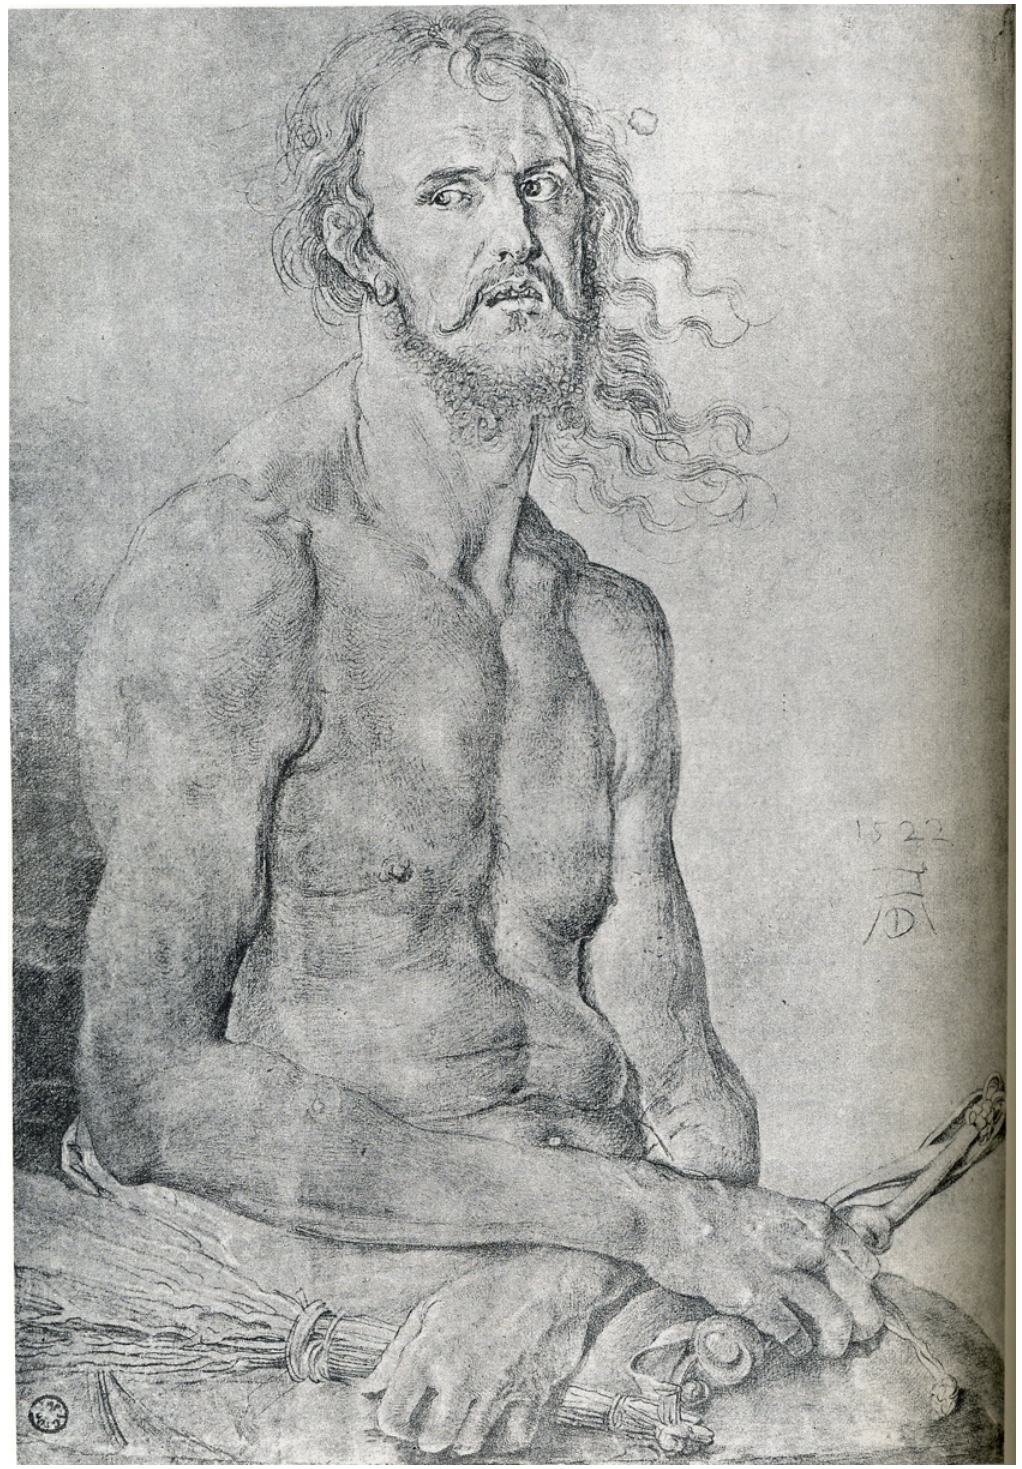
Figure 24. Albrecht Dürer, Self-Portrait as Man of Sorrows, ink drawing, 1522 (formerly Bremen, Kunsthalle, lost).